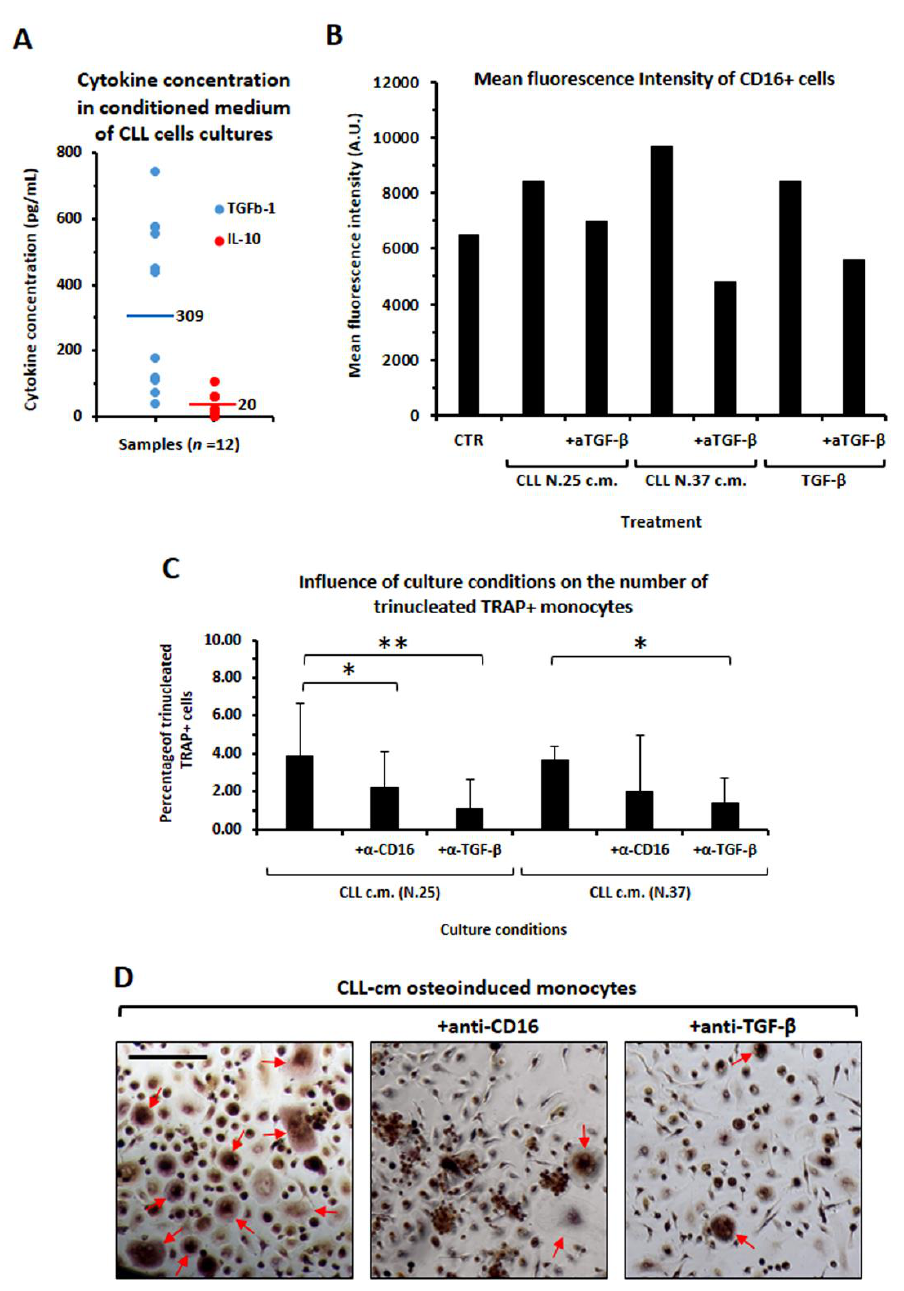
Figure 7. Determination of IL-10 and TGF β concentration in CLL-conditioned media and evaluation of the osteoclastogenesis inhibition by anti-TGF β and anti-CD16 antibodies. ( A ) Elisa quantification of IL-10 and TGF β in CLL-cm from 12 patients revealed the presence of moderate levels of IL-10 (mean: 20 pg/mL) and more consistent concentration of TGF β (mean: 309 pg/mL). ( B ) The up-regulation of CD16 expression in purified monocytes due to CLL-cm treatment or to TGF β stimulation was counteracted by the addition of the anti-TGF β antibody. Results from two assessed CLL cases (CLL N.25, CLL N.37) are depicted. ( C ) Histograms display the reduction in classical osteoclastogenic differentiation (MCSF + RANKL) in monocytes pre-stimulated with CLL-cm in presence of anti-CD16 or -TGF β antibodies. Statistical significance was determined by using ANOVA and Tukey’s post hoc test. ( D ) Monocytes pre-stimulated with CLL-cm in the presence of an anti-CD16 or -TGF β antibodies gave rise to a lower number of multinucleated TRAP+ osteoclasts (arrows), as depicted in images from a representative experiment (CLL-cm N.37). Presented images were acquired at the same enlargement. Bars correspond to 25 µm.